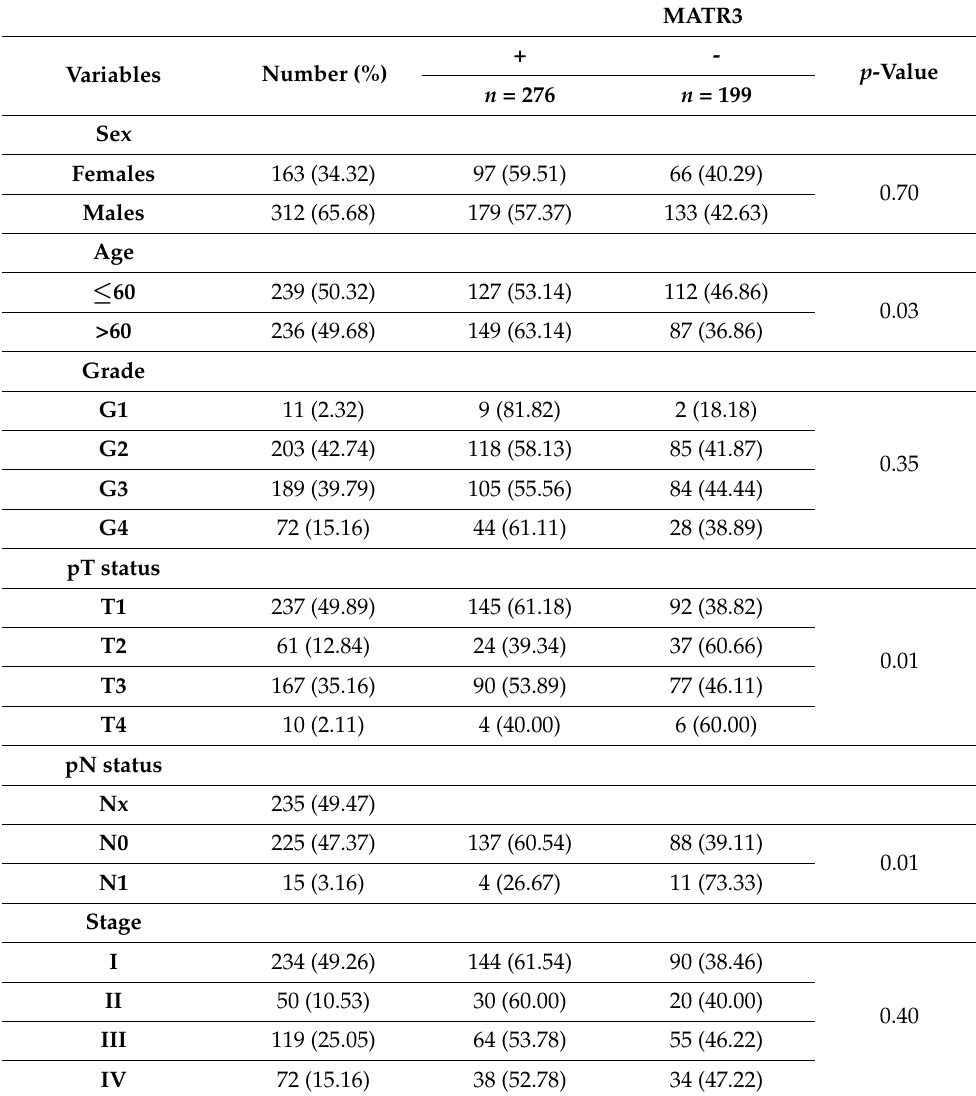
Table 3. MATR3 mRNA expression and its relationship with clinicopathological features of clear cell renal cell carcinoma (ccRCC) patients in the TCGA cohort. “-” indicates low expression; “+” indicates high